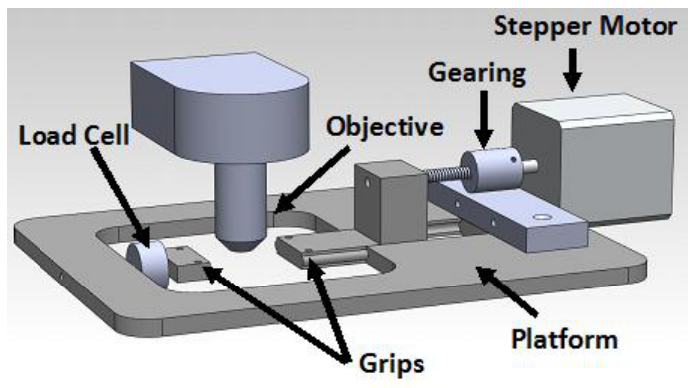
Figure 9. Schematic of a loading machine used to generate stress on the skin